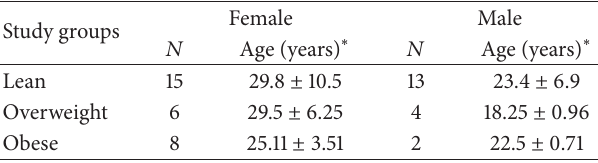
Table 1: Distribution of age and sex of the chimpanzees in the